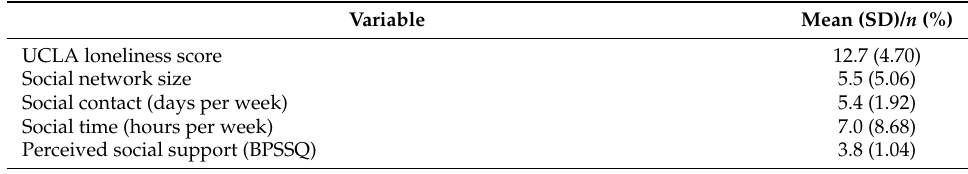
Table 2. Participant loneliness, wellbeing, and social activity including social